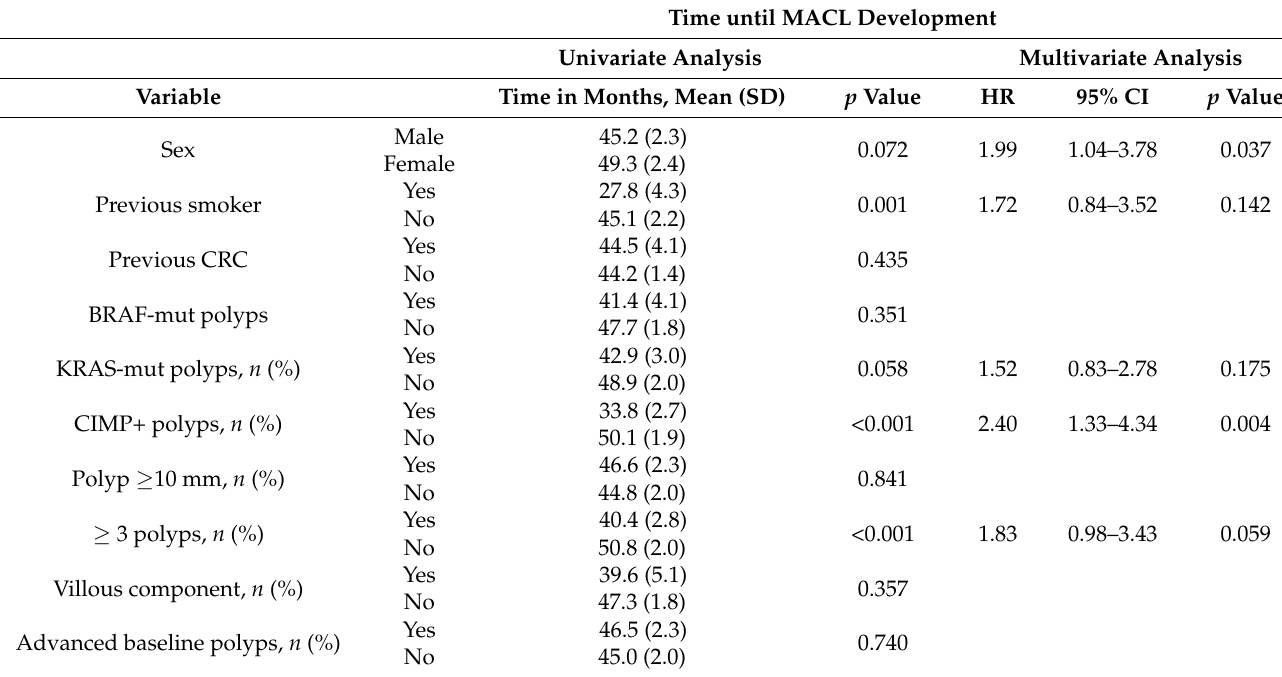
Table 4. Time until MACL development according to potential risk factors.